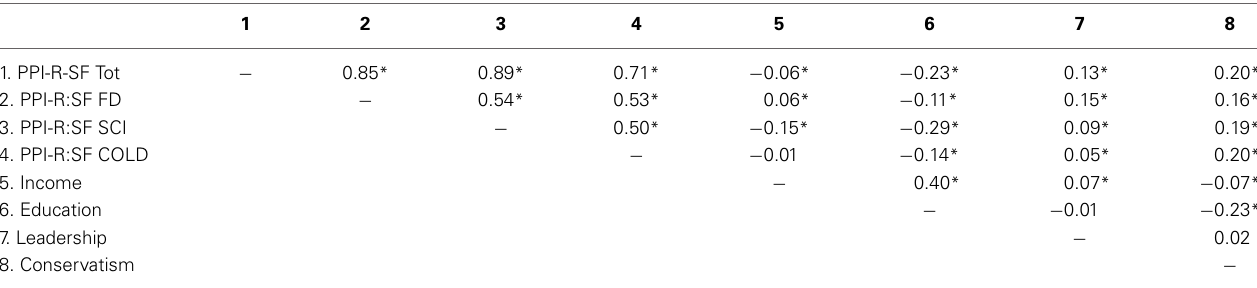
Table 2 | Correlations among dimensional variables.